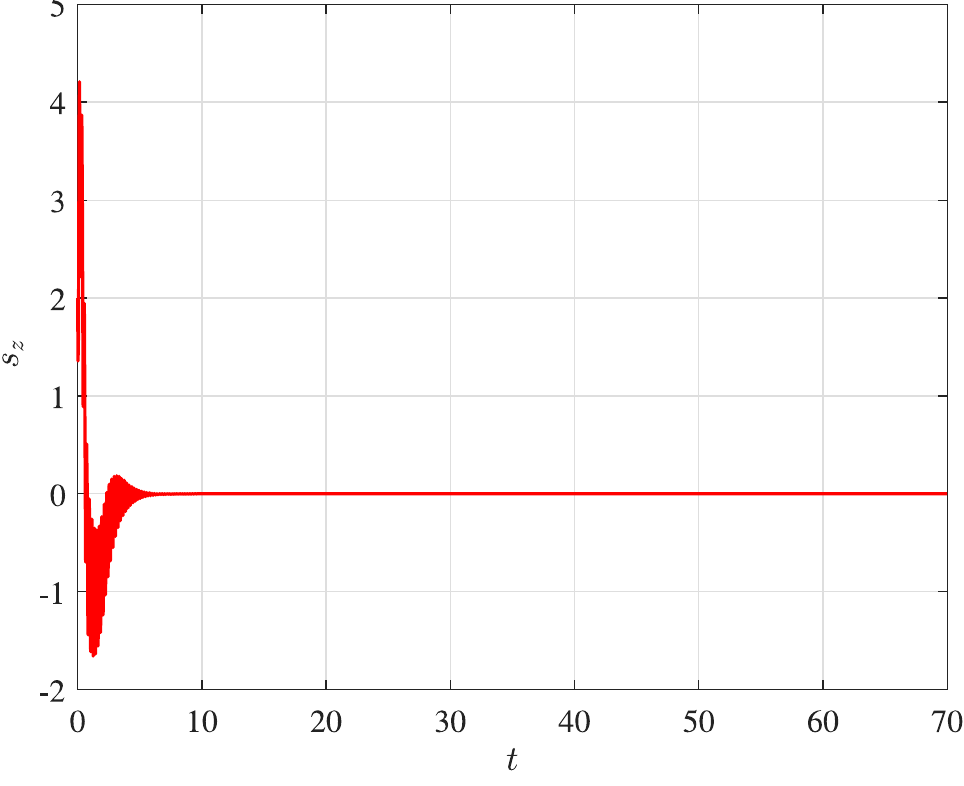
Figure A2. Sliding surface in the vertical direction.